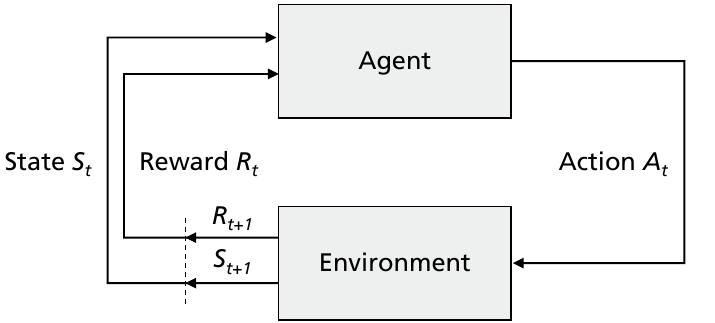
Figure 4. Description of an agent-environment interaction by a Markov Decision Process